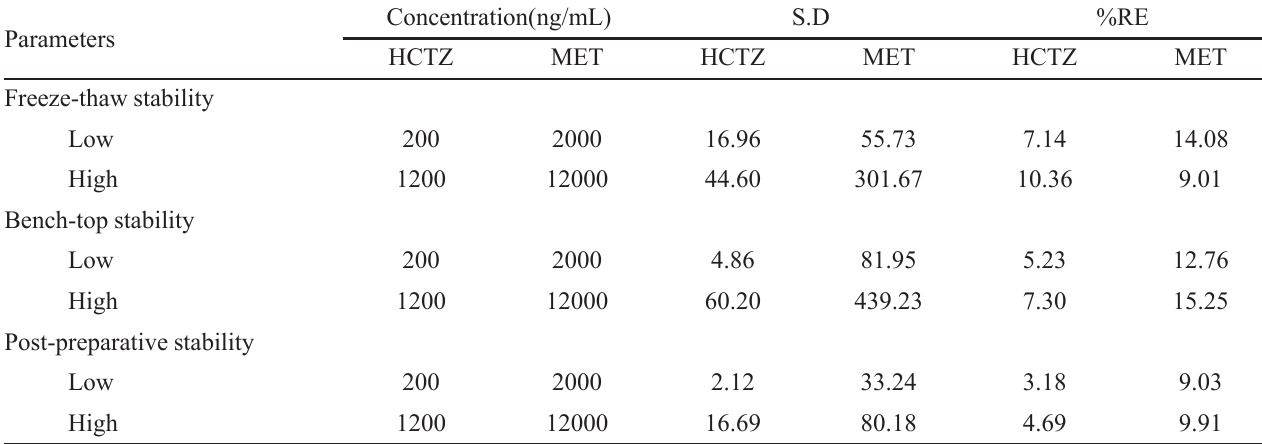
TABLE III - Stability study of metoprolol tartarate and hydrochlorothiazide in human plasma